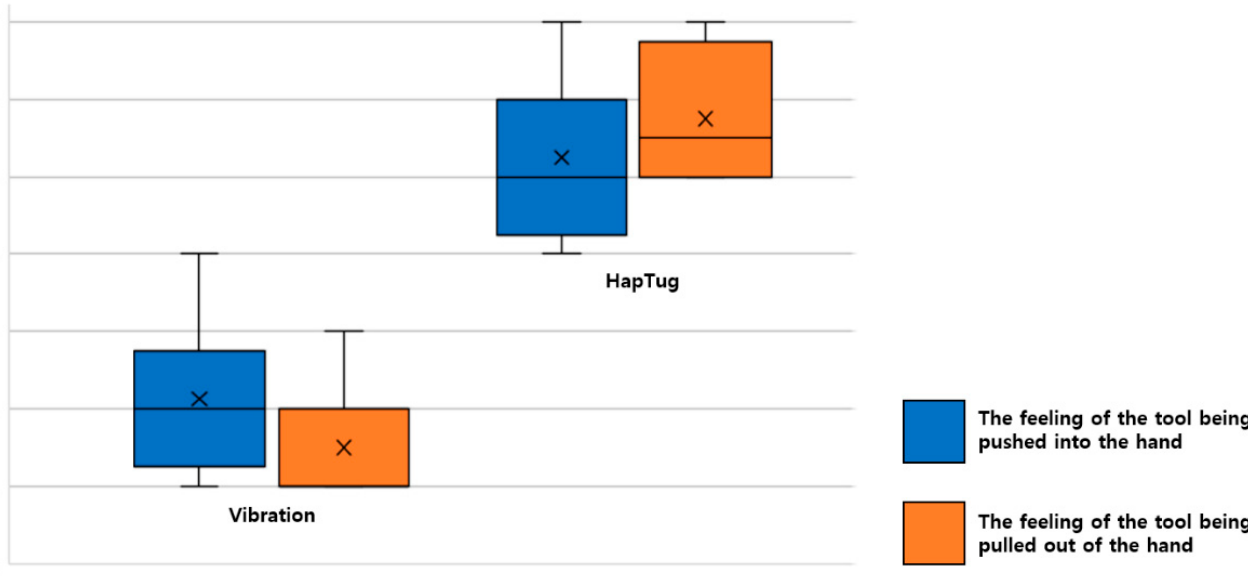
Figure 5. The seven-point Likert scale scores of vibrations and HapTug for two sensations.